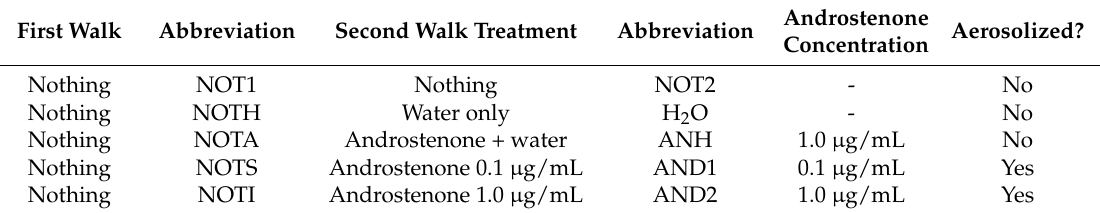
Table 2. Walking study treatments and associated abbreviations. These abbreviations will be used for the remainder of this